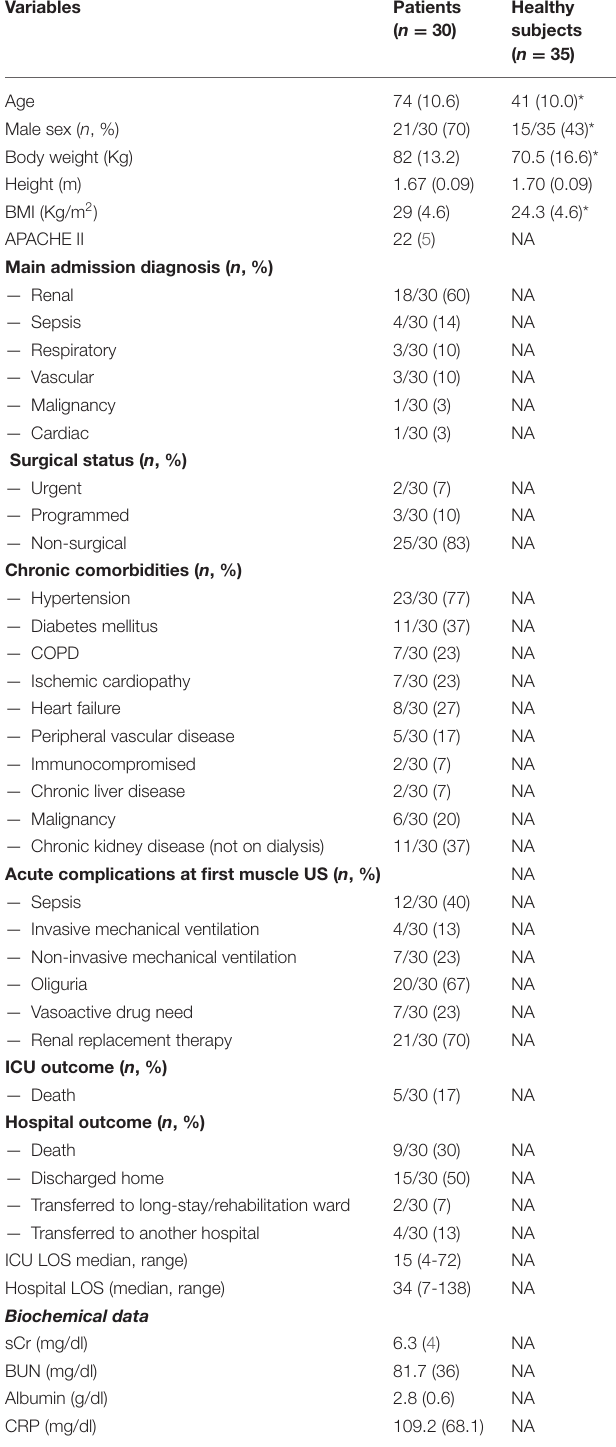
TABLE 1 | Demographic and clinical